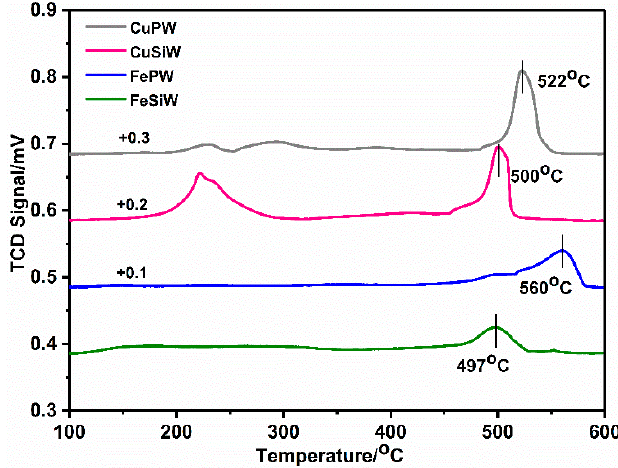
Figure 4. NH 3 -TPD curves of the as-synthesized heteropolyacid salt samples.